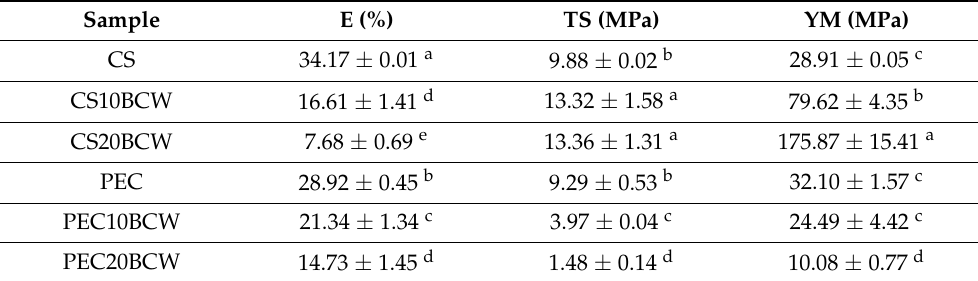
Table 2. Mechanical properties of the tested film formulations expressed as elongation at break (E), tensile strength (TS) and Young’s modulus